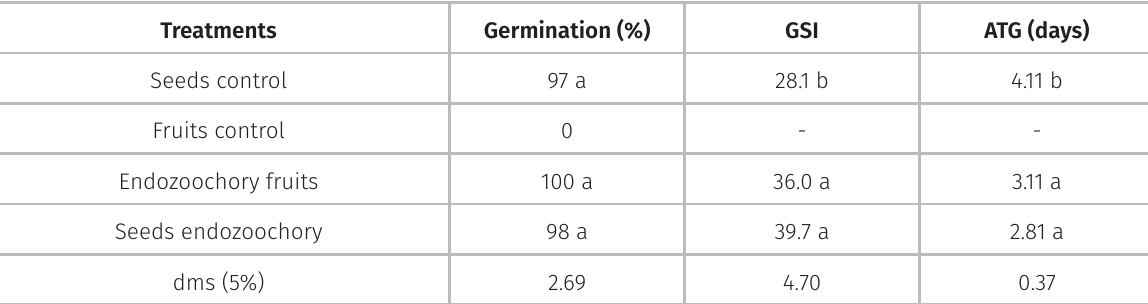
Table I. Germination (%), germination speed index (GSI), and average time of germination (ATG) in the germination